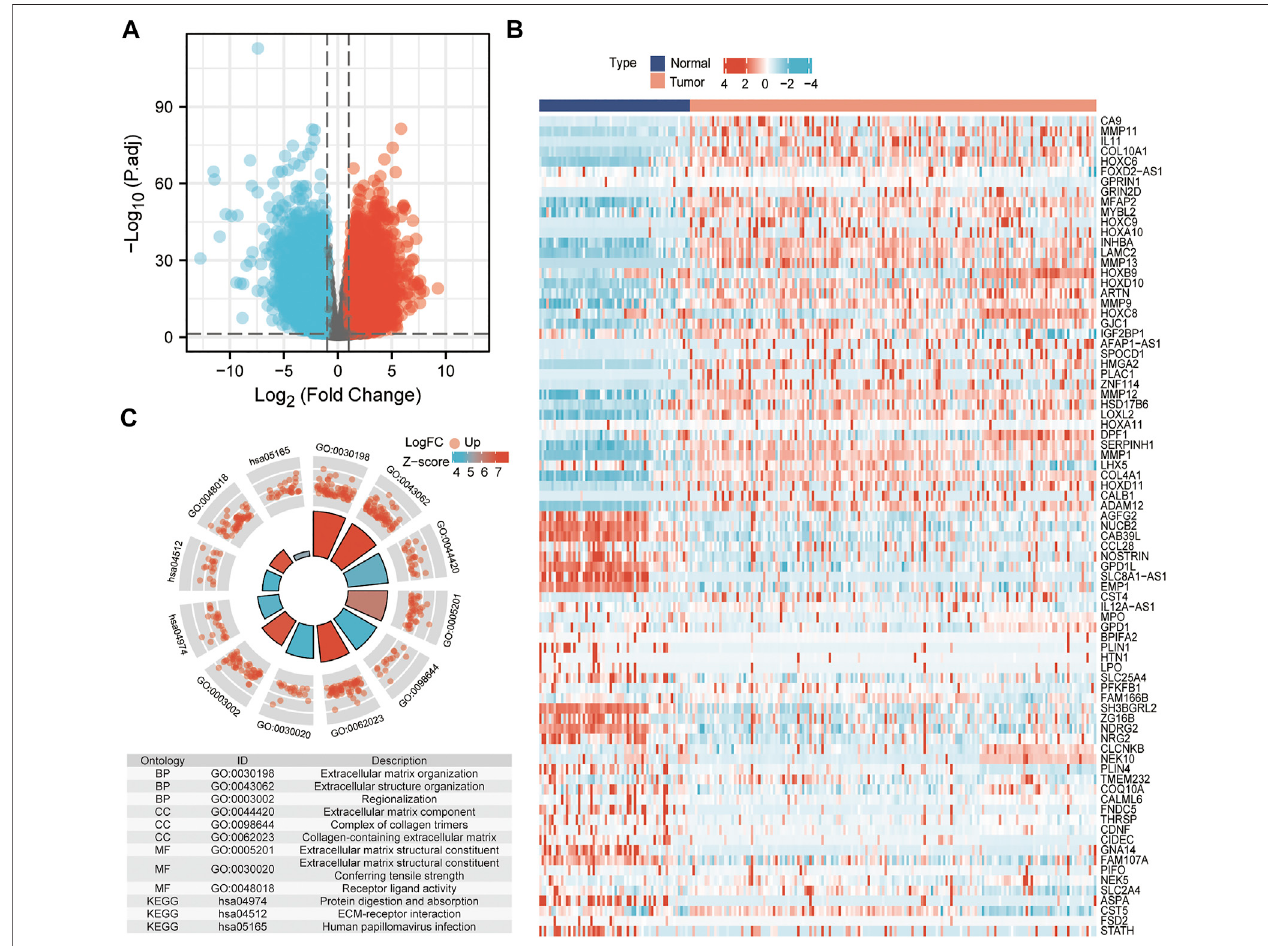
FIGURE 1 | Identi fi ed differentially expressed genes. (A) Volcano plot: up-regulated and down-regulated genes were indicated in red dots and blue dots, respectively. (B) Heatmap of the differentially expressed genes. (C) GO terms and KEGG pathways enrichment analysis.